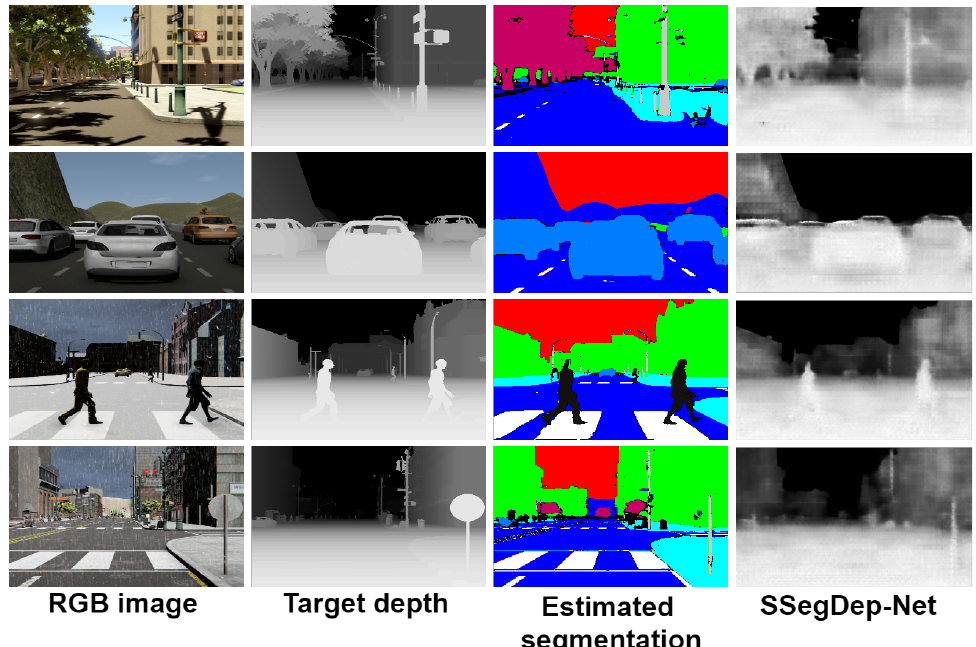
Figure 21. Results from the SSegDep-Net visually enhanced; this model uses the estimated segmenta- tion given by the